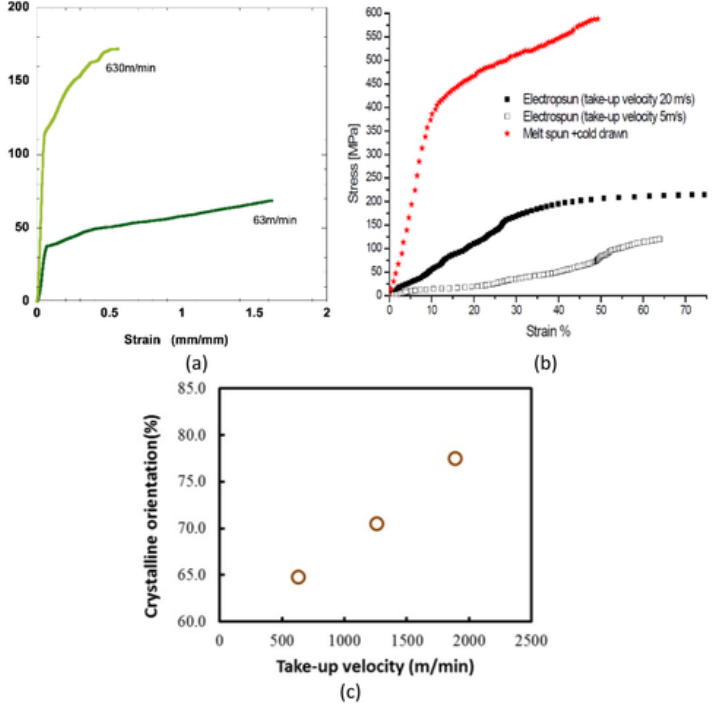
Figure 26. ( a ) Tensile stress–strain curves for PLLA nanofibers at different take-up velocities of 63 and 630 m/min. ( b ) Stress–strain curves of single polyamide-66 (PA-66) nanofibers collected at take-up velocities of 5 and 20 m/s and commercial PA-66 microfiber. ( c ) Crystallinity orientation for take-up velocities of 630, 1260, and 1890 m/min. Reproduced with permission: ( a ) [180] Elsevier, ( b ) [115] AIP Publishing, and ( c ) [181] John Wiley and